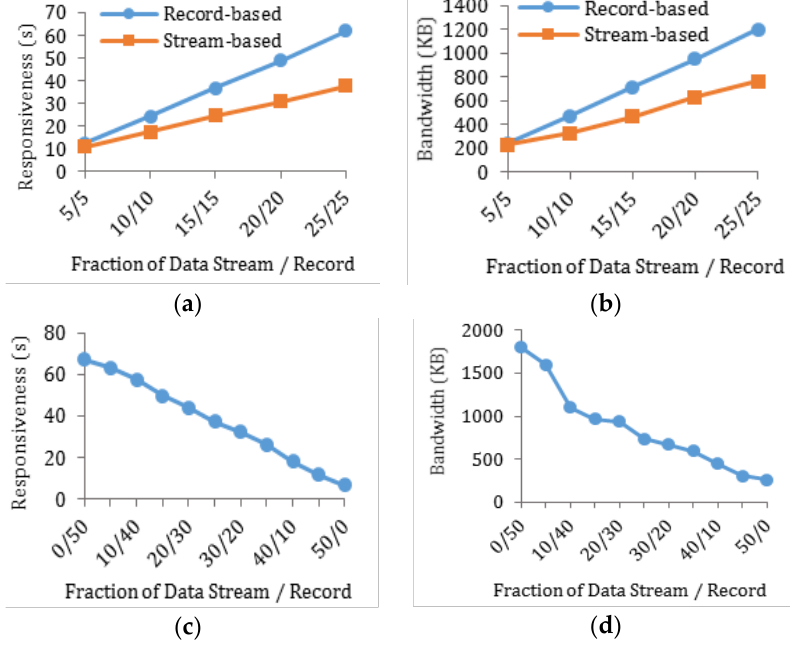
Figure 9. Communication overhead in sharing both data stream and records through record-based and stream-based digest generation, measured in ( a ) responsiveness and ( b ) bandwidth. Communication overhead of MedChain in different fraction of data stream to record, measured in ( c ) responsiveness and ( d ) bandwidth.